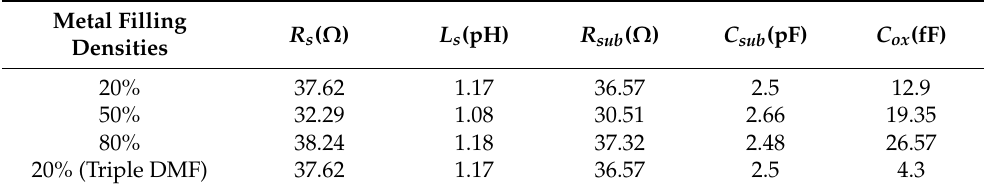
Table 4. Parameters of lumped devices for single π -circuit model at different DMF densities.